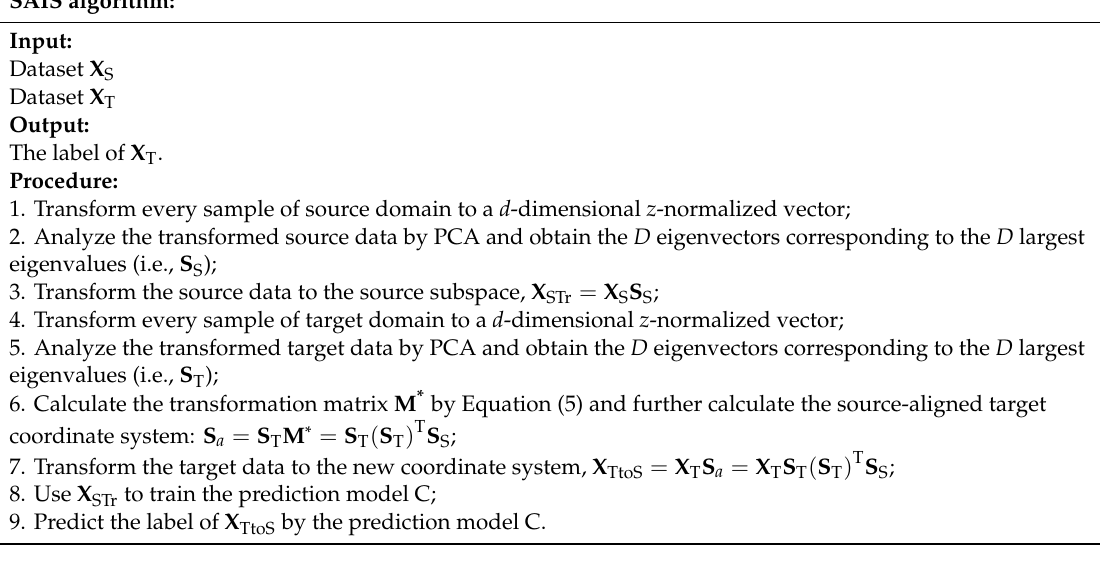
Table 3. Procedure of SAIS